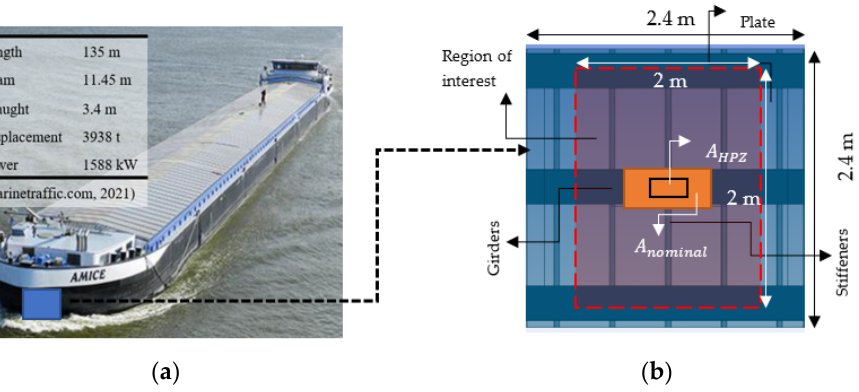
Figure 4. A representative inland waterway barge in Lake Mälaren shown in ( a ) is used as basis to develop a reference hull plate shown in ( b ).